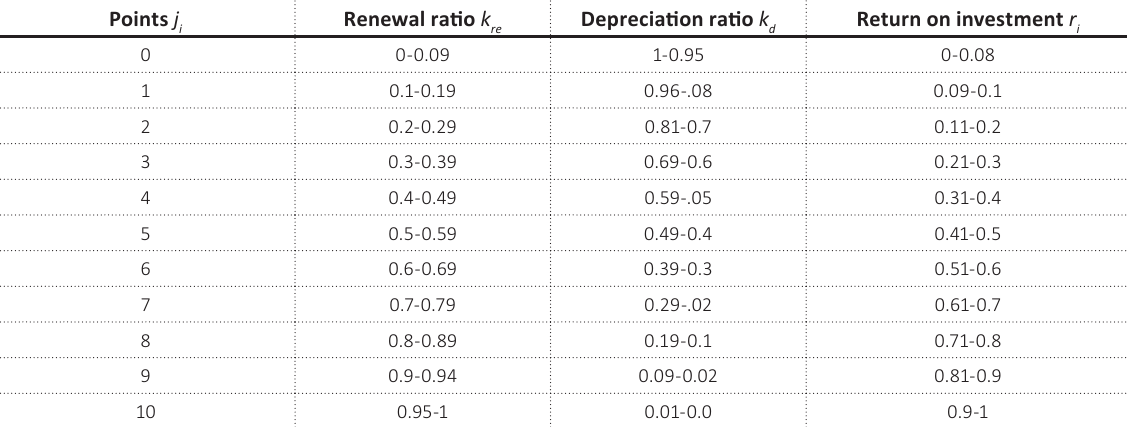
Table 1. Scale of converting the component’s values of the general indicator of the property status into